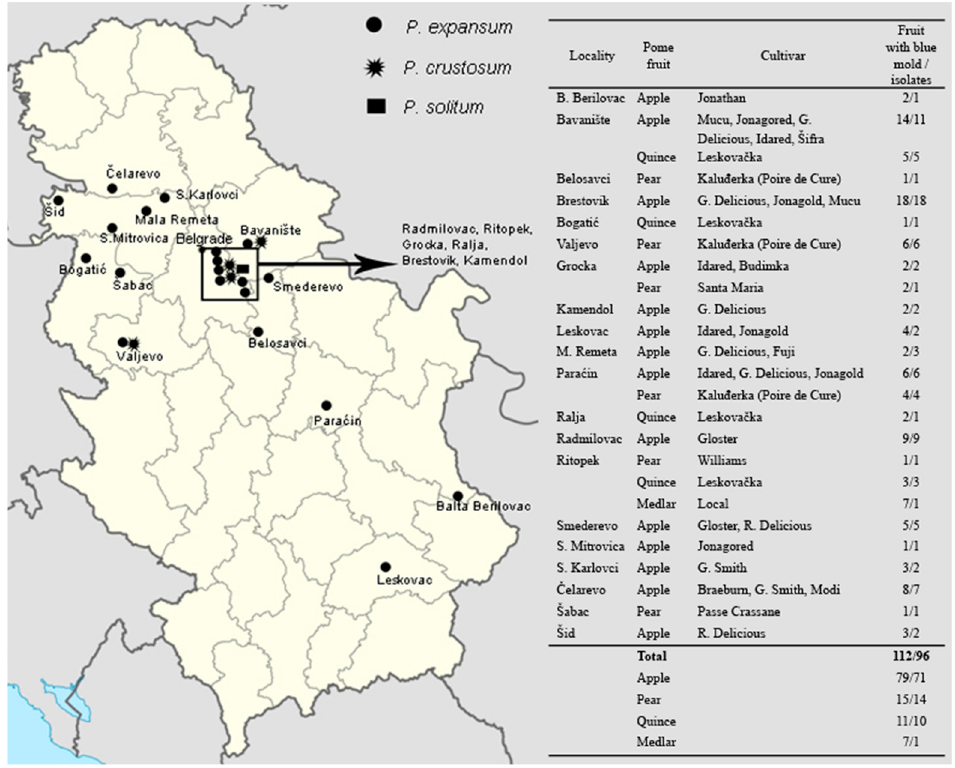
Figure 1. Map of Serbia showing different locations where Penicillium spp. isolates from pome fruits were obtained.